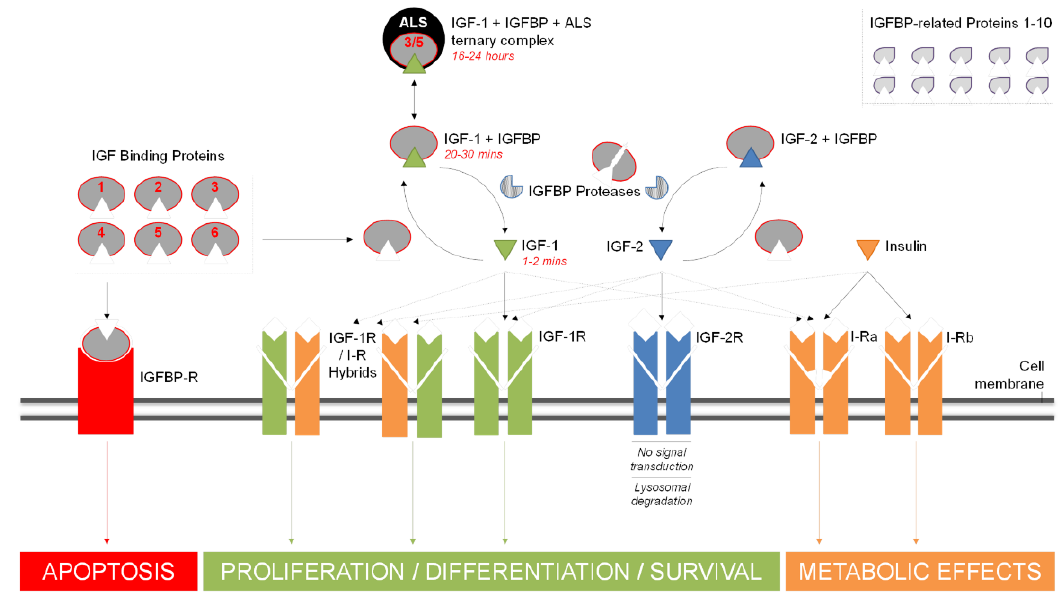
Figure 2. Insulin-like growth factor-1 (IGF-1) is part of a wider network of growth factors, receptors and binding proteins involved in mediating cellular proliferation, differentiation and survival. In addition to IGF-1 two other polypeptides, Insulin-like growth factor-2 (IGF-2) and insulin feature prominently, as well as multiple membrane-bound receptors including the type-1 and type-2 IGF receptors (IGF-1R and IGF-2R), two insulin receptor isoforms (I-Ra and I-Rb), a number of hybrid receptors between the insulin and IGF-1 receptors (IGF-1R/I-R) and the two I-R isoforms themselves (not shown). All three peptides bind to their respective receptors with the highest affinity (denoted by solid black arrows) but also share some crossover affinity with each other’s receptors (dashed arrows). The bioavailability of IGF-1 and IGF-2 is regulated by a group of six insulin-like growth factor binding proteins (IGFBPs) that chaperone the peptides in circulation. A majority of IGF-1 is bound to IGFBP3 or 5 and the acid-labile subunit (ALS), forming a ternary structure known as the IGF-1-IGFBP-ALS complex. Half-life times for bound and unbound IGF-1 are shown in red italics. Cell surface interactions or IGFBP proteolysis frees IGF-1 to bind its receptor. IGF-2 further regulates IGF-1 signalling by binding to the IGF-1R. Whilst the IGF-2R does not participate in signalling, it does lead to lysosomal degradation of IGF-2, thus reducing competition for the IGF-1R when required. IGFBPs also show an IGF-independent role, binding to a potential IGFBP receptor (IGFBP-R) and promoting apoptosis via signalling pathways and/or intracellular activity after internalisation by the cell. IGFBP-related proteins (IGFBP-rPs, shown top right) are another class of molecules involved in the IGF network with affinity for IGFs, albeit at lower affinities than the